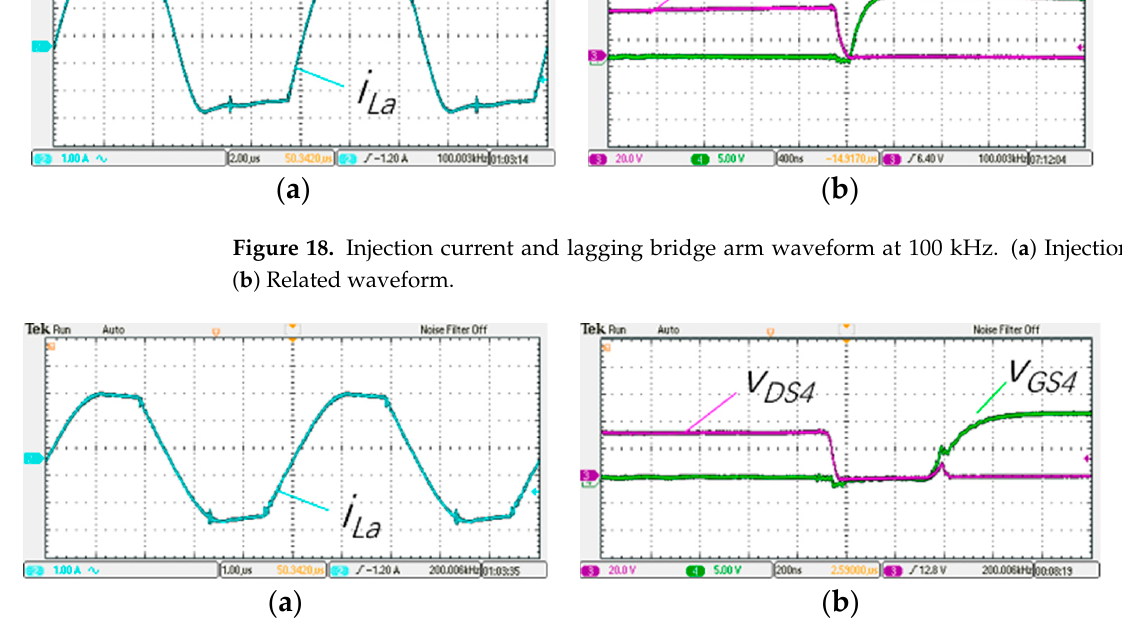
Figure 19. Injection current and lagging bridge arm waveform at 200 kHz. ( a ) Injection current; ( b ) Related waveform.